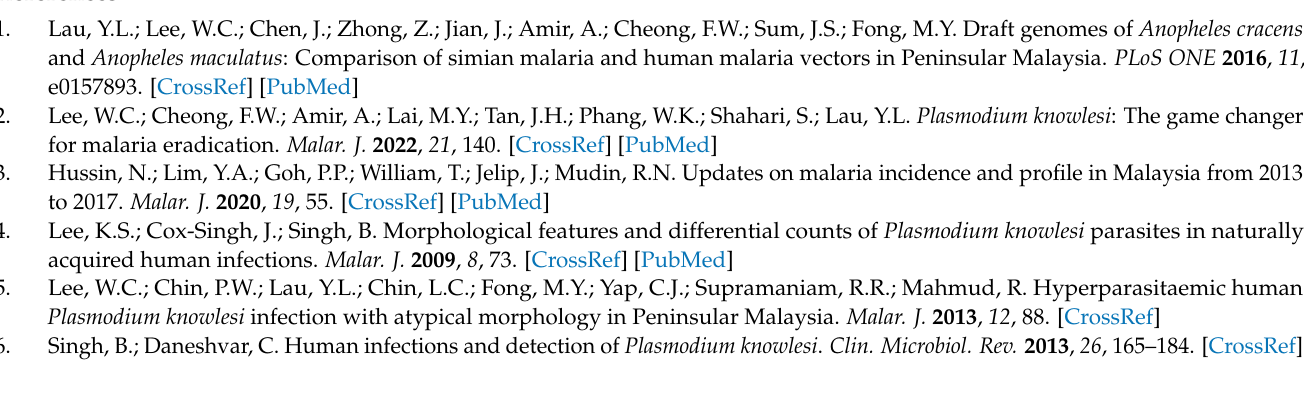
antigen 1. Figure S5. Schematic structures and sequences of P. knowlesi AMA-1, P. vivax AMA-1, and P. falciparum AMA-1. (A) Schematic structures of P. knowlesi AMA-1 (PkAMA-1), P. vivax